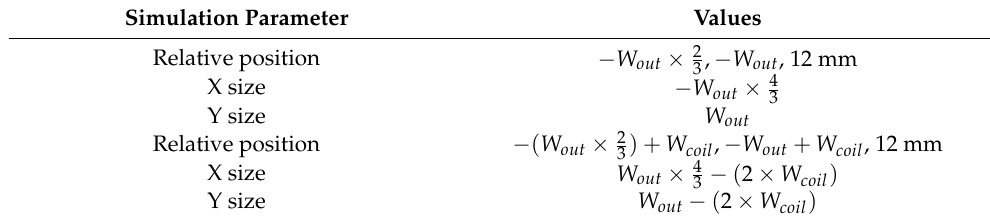
Table 5. FEA Parameters of the DD structure